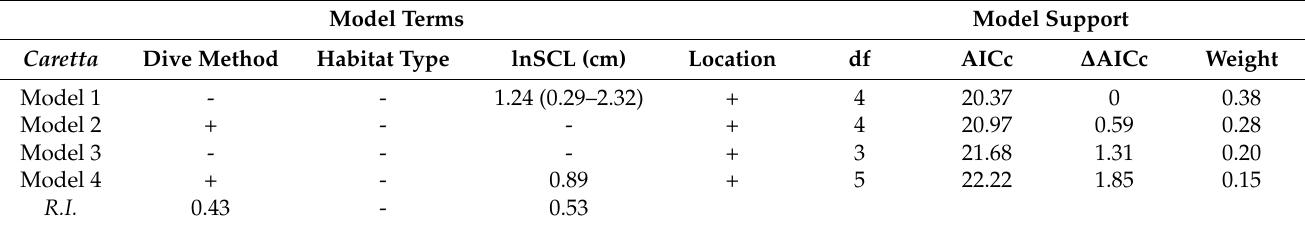
Table 4. Confidence set for linear mixed effects model examining the relationship of loggerhead sea turtle minimum approach distance and biological factors ( ∆ AICc < 2). Note: (+) symbol indi- cates variable was included in the model and (-) indicates variable was not included in the model. AICc = Akaike’s Information Criterion corrected for small sample size, ∆ AICc = difference in AICc from the top ranked model, R.I. = relative